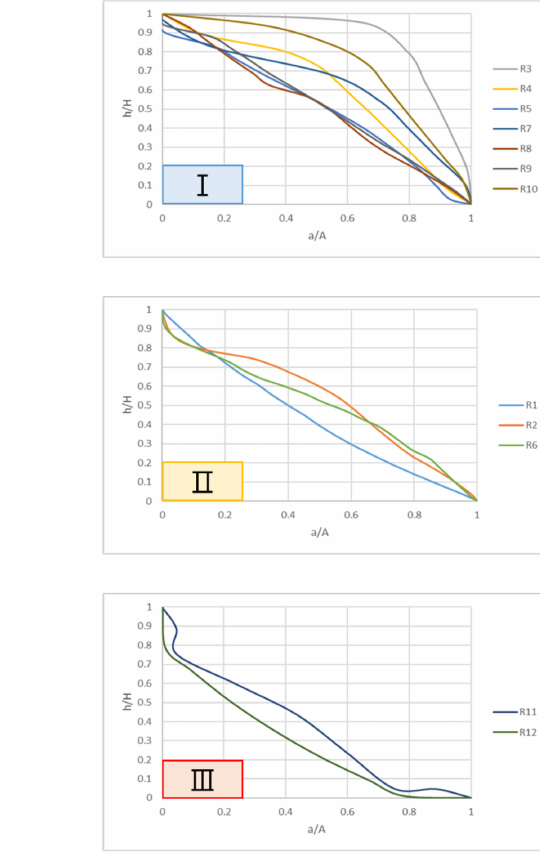
Figure 10. Morphological analysis of the collapsed reservoirs using cluster analysis and